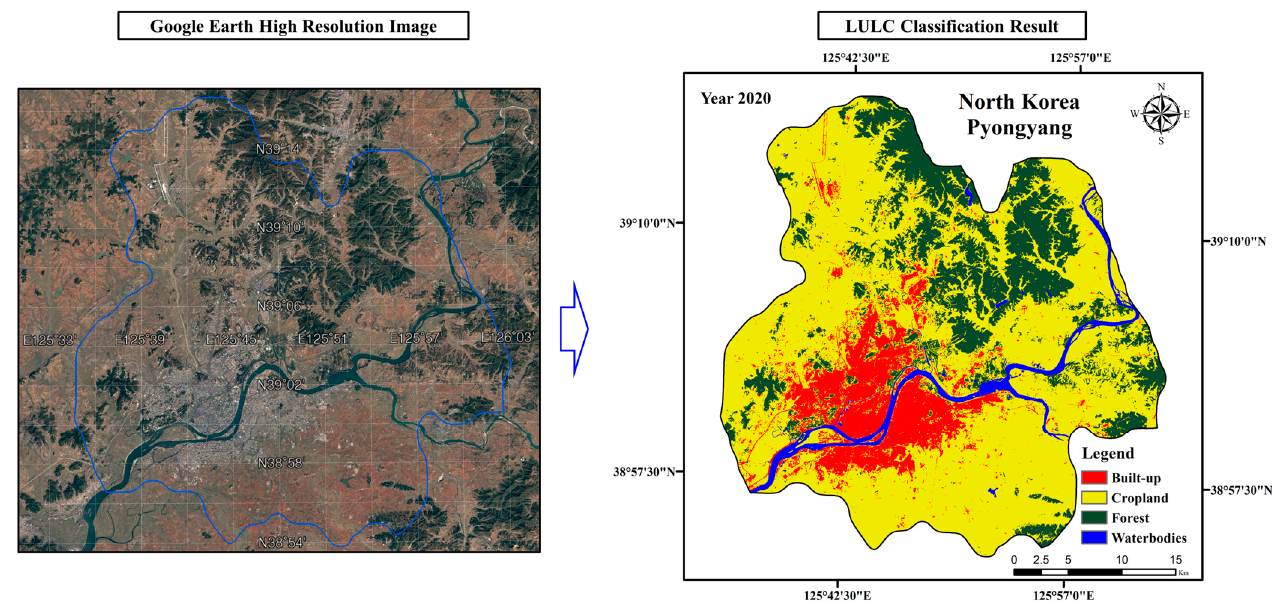
Figure 4. Visualizing interpretation compared with a Google Earth high-resolution image from 2020.